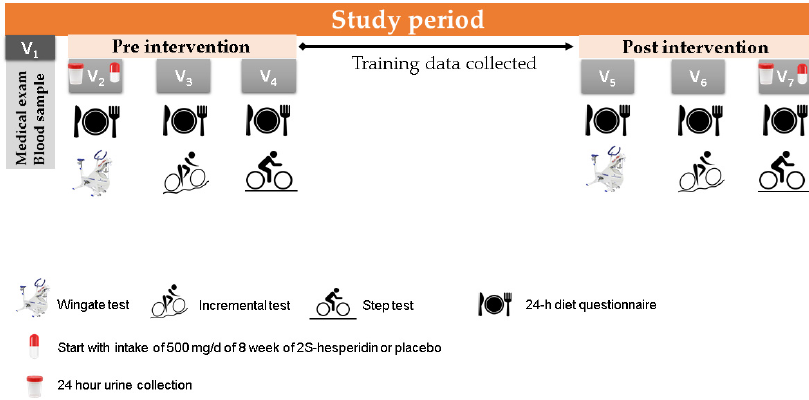
Figure 2. Study planning with explanation of the different visits (V 1–7). Table 2. Between-group comparisons in dietary intake of cyclists.